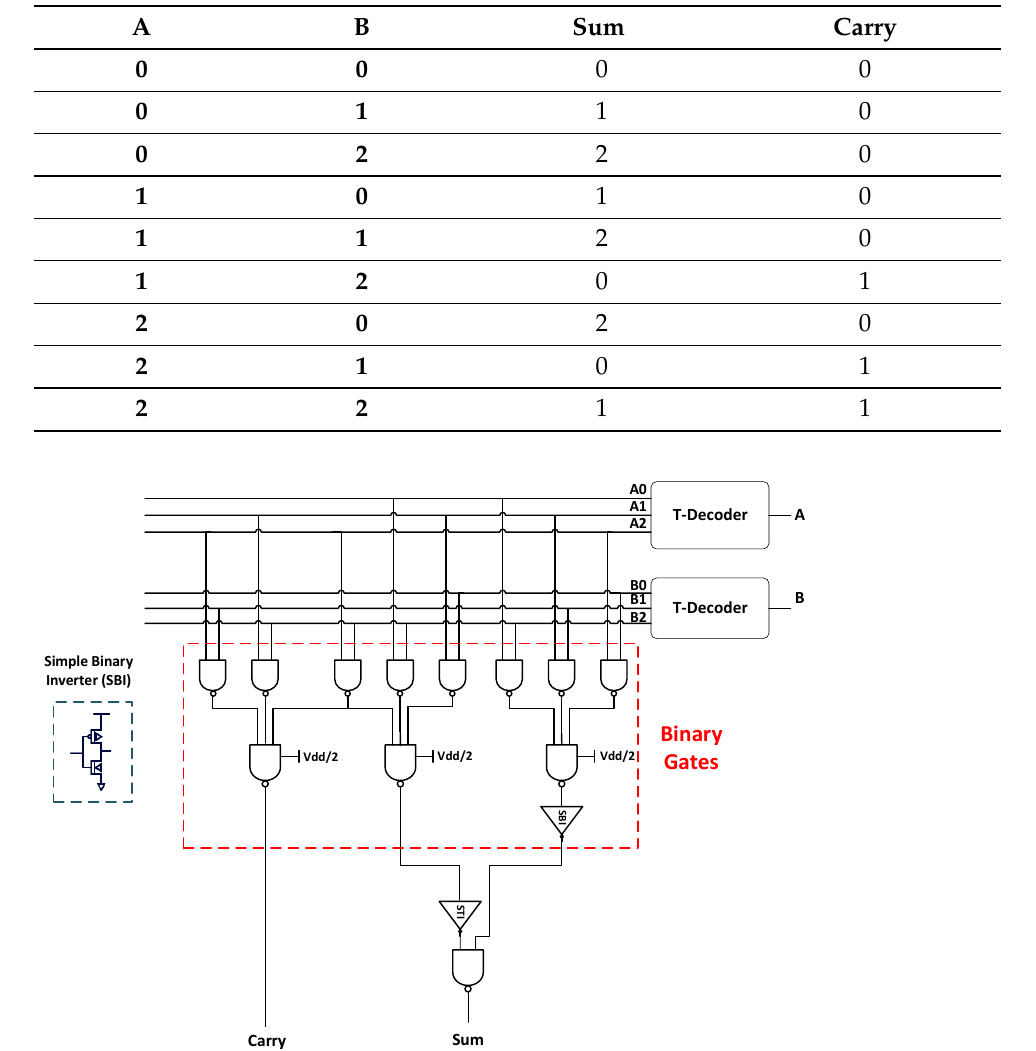
Figure 3. Single-trit half adder